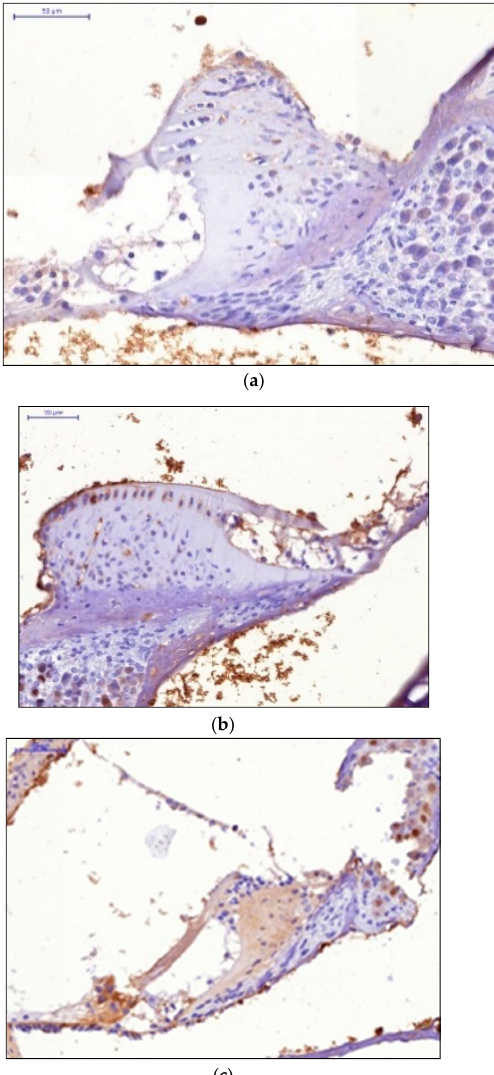
Figure 2. HIF-1 expression in the cells of the receptor apparatus and the cells of the spiral ganglion: ( a ) Therapeutic dose 5 mg/kg; ( b ) Therapeutic dose 7 mg/kg; ( c ) Therapeutic dose 10 mg/kg. The preventive use of the drug 3 days before the acoustic load in the dose of 5 mg/kg resulted in moderate HIF-1 expression by the hair cells, low-level expression in the cells of the spiral ganglion. Administration of the dose of 7 mg/kg resulted in moderate HIF-1 expression in the cells of the receptor apparatus and the cells of the spiral ganglion. Injec- tion of the dose 10 mg/kg resulted in pronounced HIF-1 expression in the cells of the re- ceptor apparatus and the cells of the spiral ganglion (Figure 3).